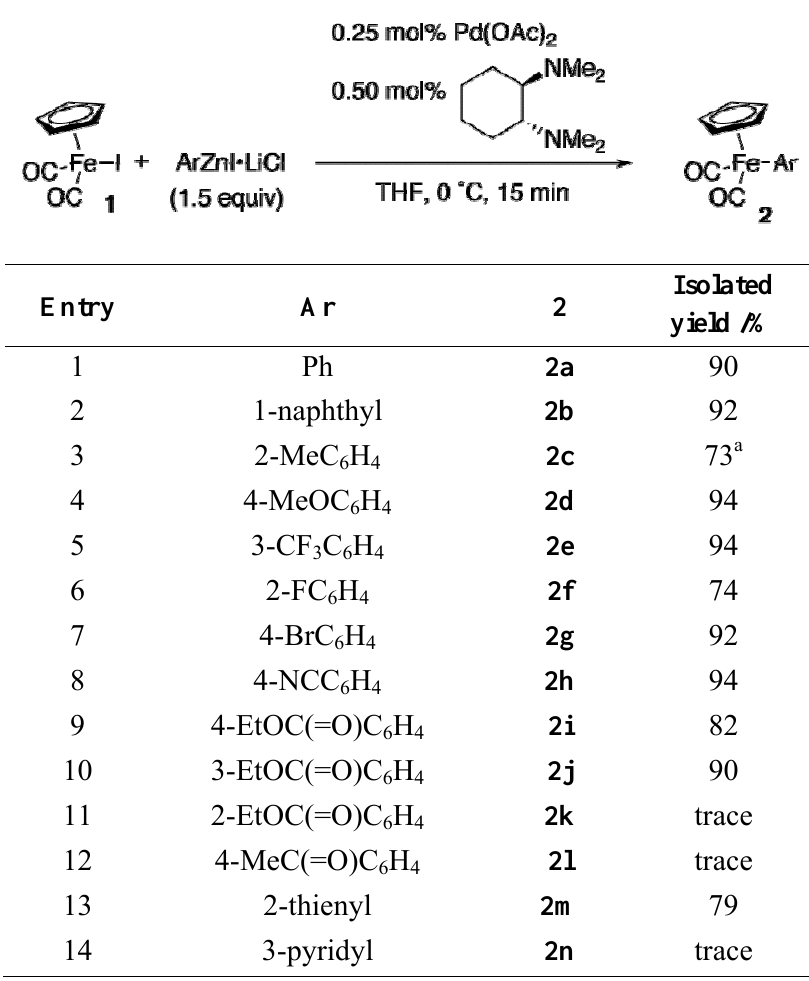
Table 2. Palladium-Catalyzed Arylation of [CpFe(CO)